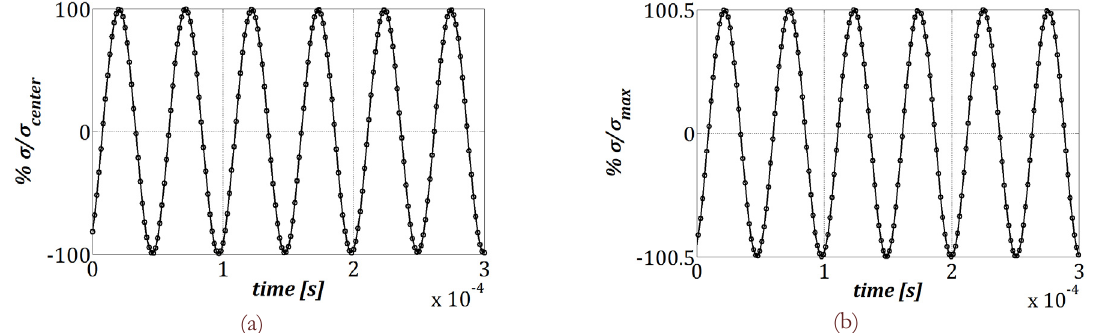
L ; (b) rosette at 3